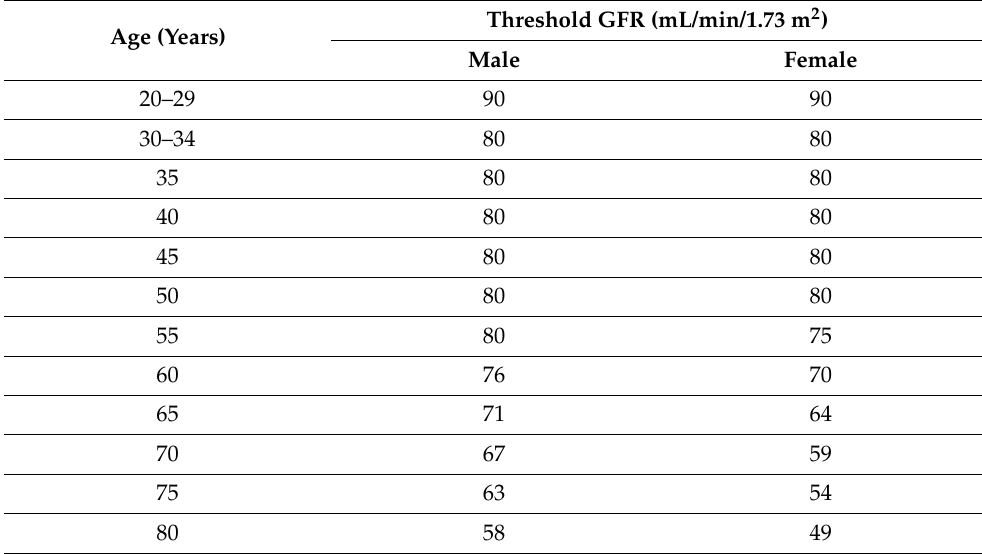
Table 1. Identification of age-related kidney function safe thresholds to